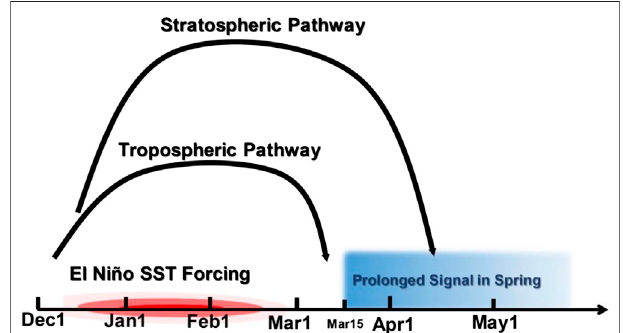
FIGURE 1 | Time periods of imposed idealized EN – SST forcing in WACCM4, and active pathways by which EN can in fl uence the Eurasian surface climate. The prolonged tropospheric signal in spring after Mar 15 is attributed solely tothestratospheric pathway,becausethe tropospheric pathway is negligible around two weeks after the termination of forcing (Dec – Jan –